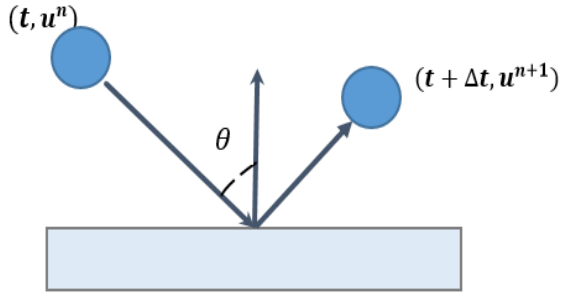
Figure 2. Illustration of momentum retention of the particle.